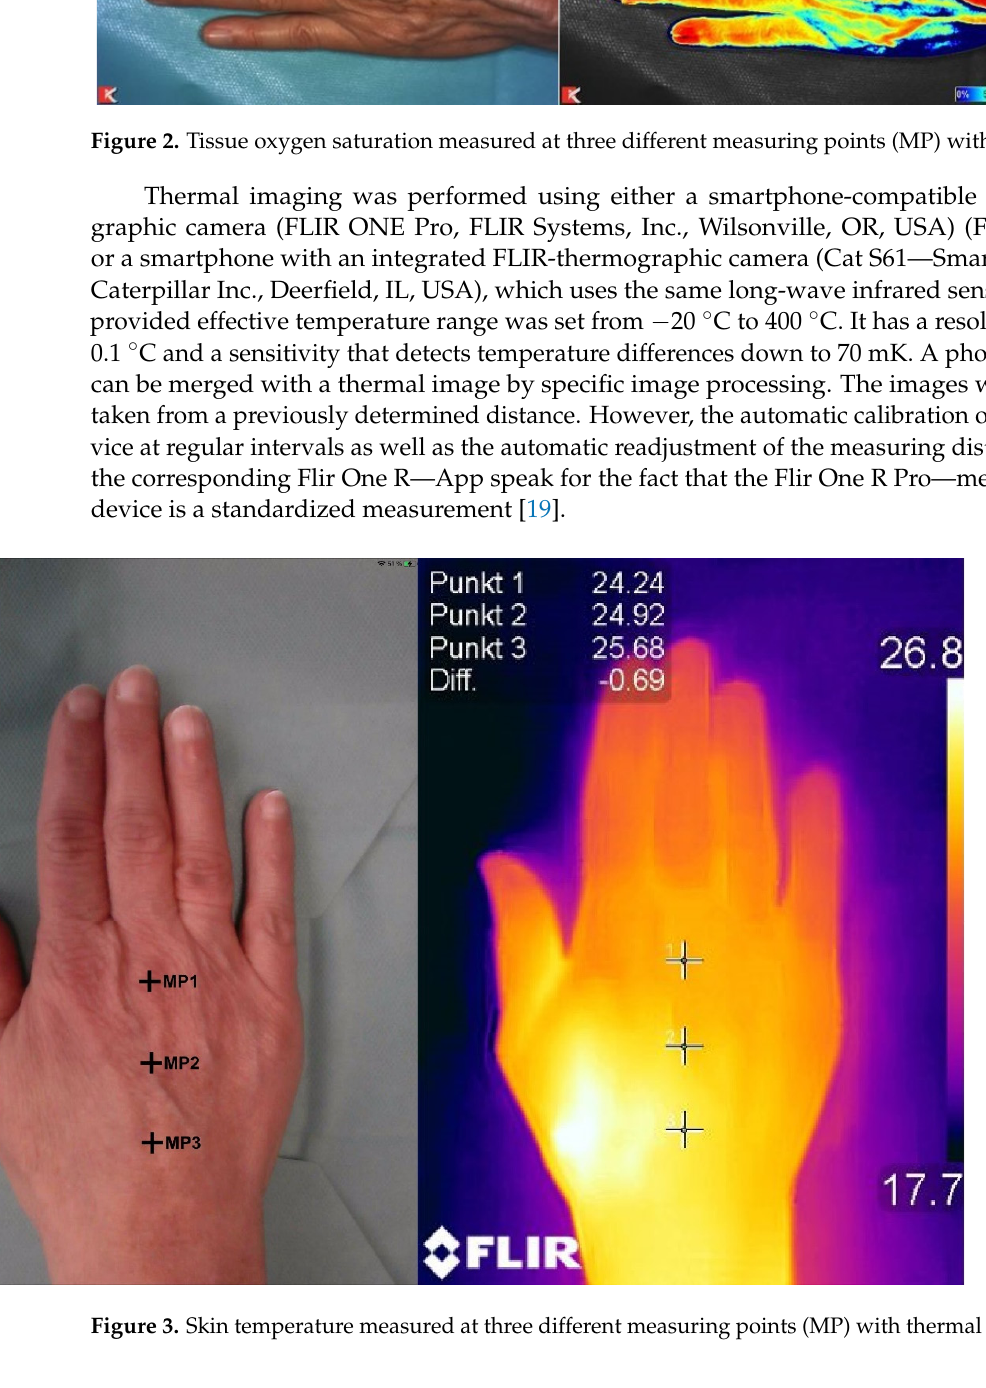
Figure 2. Tissue oxygen saturation measured at three different measuring points (MP) with NIRI.